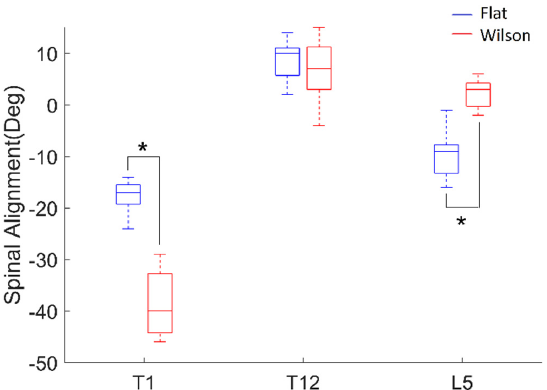
Figure 5. Spinal alignment (deg) of thoracic curvature angle at T1 and T12, and lumbar curvature angles at L5 from postures on flat (blue) and Wilson (red) tables. Each box plot indicates 25th (Q1), 50th (Q2), and 75th (Q3) data percentiles. Whisker indicates Q3 + 1.5 × (Q3 − Q1) and Q1 − 1.5 × (Q3 − Q1). *, p < 0.05.